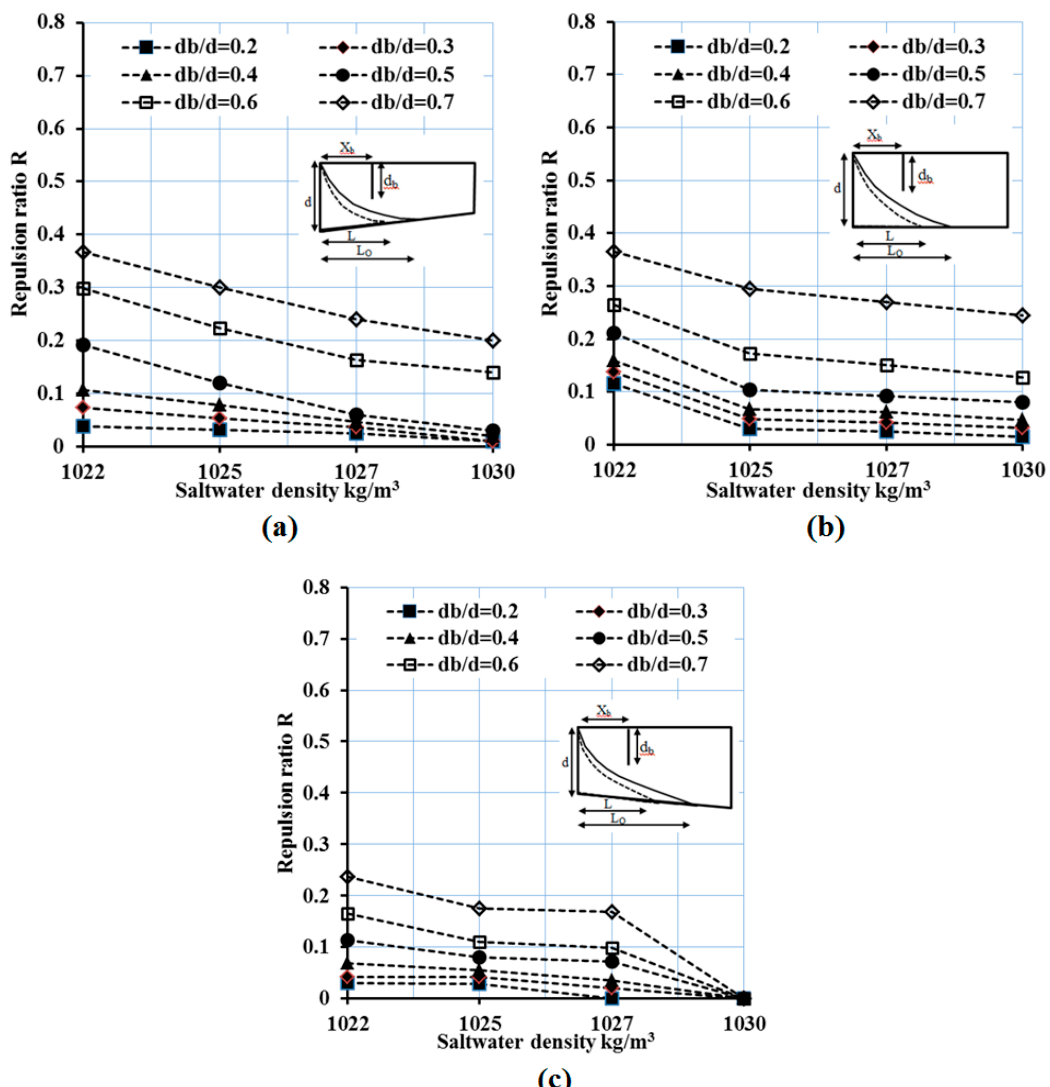
Figure 10. Relationship between saltwater density and R for different bed slopes tan β : ( a ) 0.02, ( b ) 0.0, and ( c ) − 0.02.